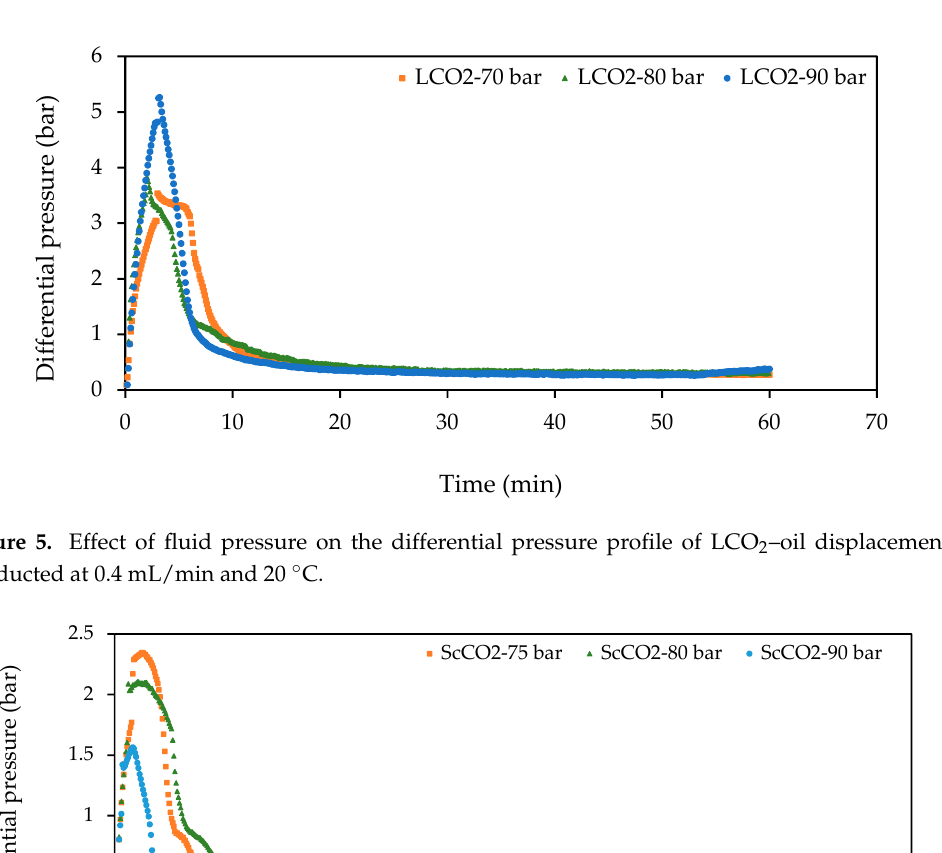
Figure 6. Effect of fluid pressure on the differential pressure profile of ScCO 2 –oil displacements conducted at 0.4 mL/min and 33 °C.